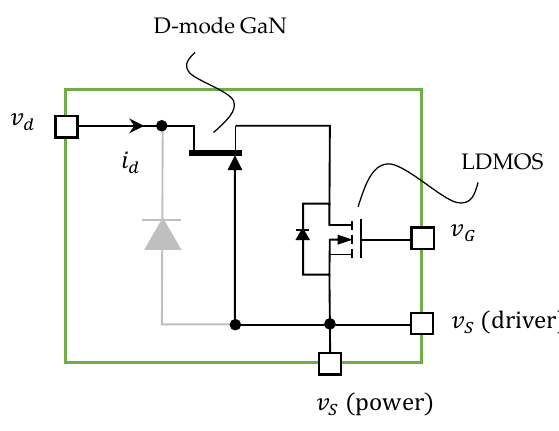
Figure 3. Conventional cascode GaN HEMT power module.